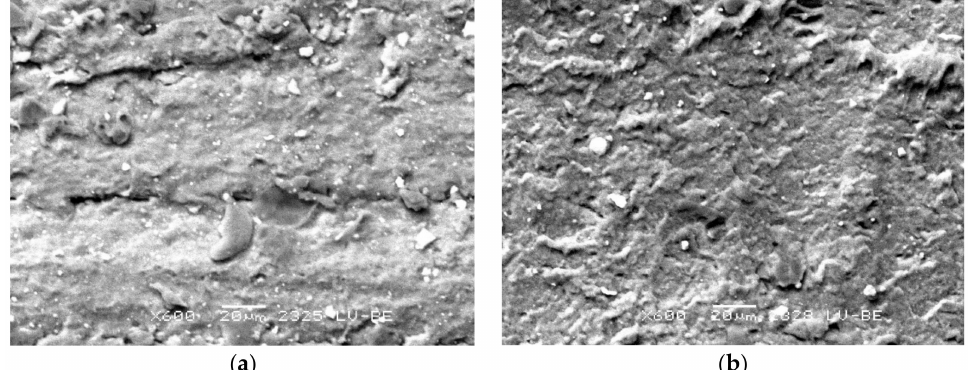
Figure 10. Sample surface—material: FKM ( a ) before the test; ( b ) after the